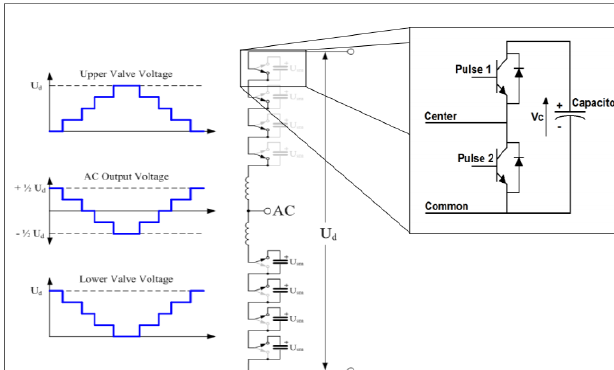
Fig. 3. Modular multilevel converter topology